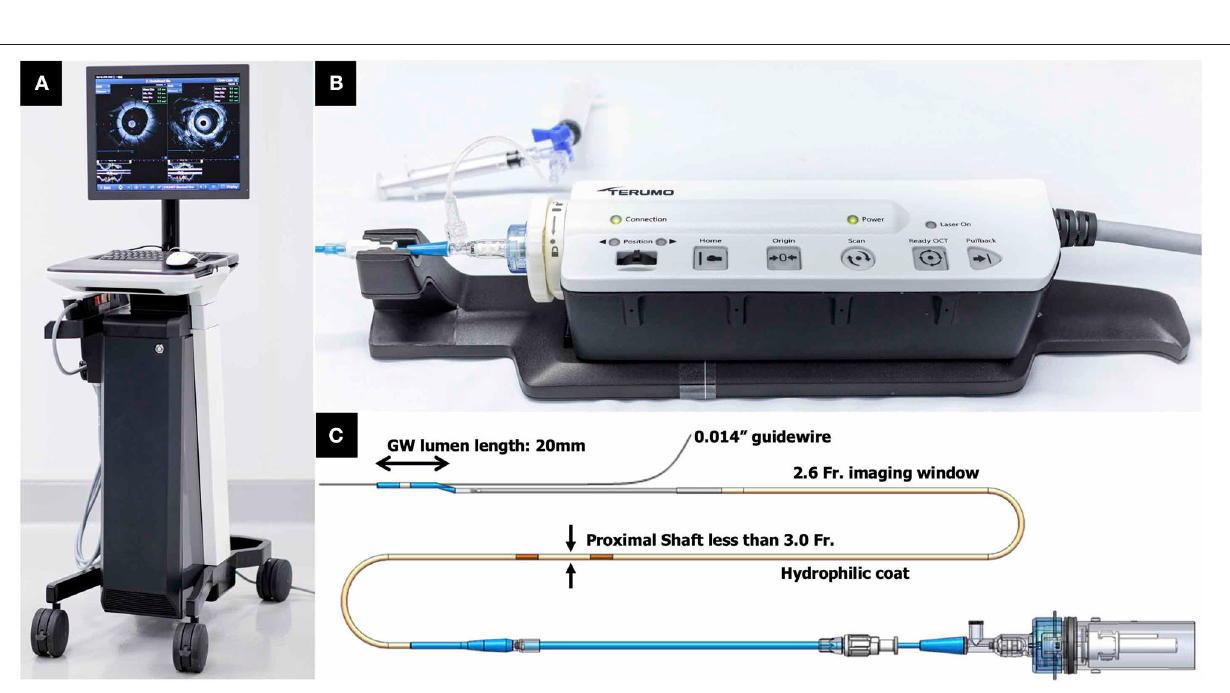
Frontiers in Cardiovascular Medicine | www.frontiersin.org